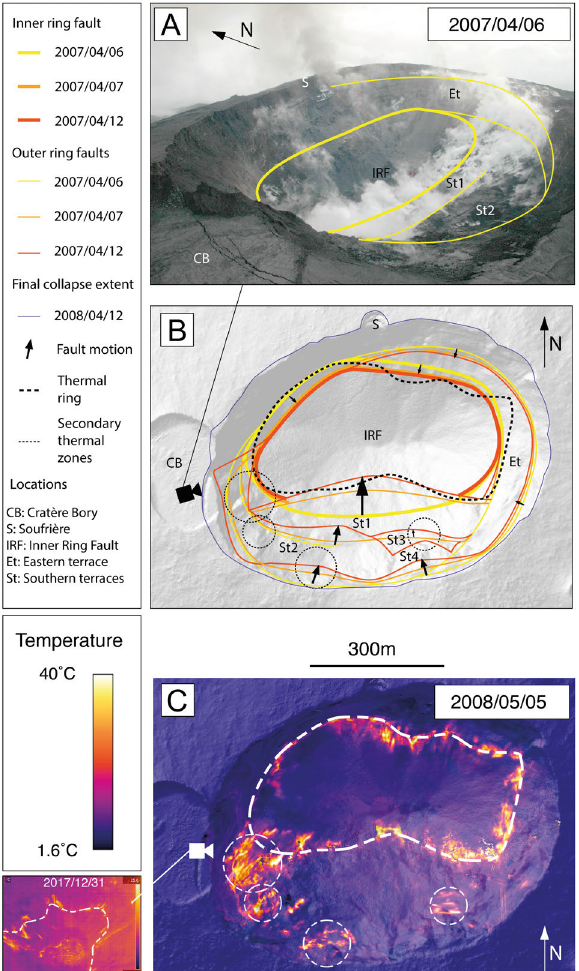
Figure 3: [A] N–S cross-sections of the successive DEMs made for 2007, with dates given in mm/dd format. [B] E–W cross-sections of the successive DEMs made for 2007. [C] Time series of the caldera volume evolution. See location of the cross-sections on Figure 2A.